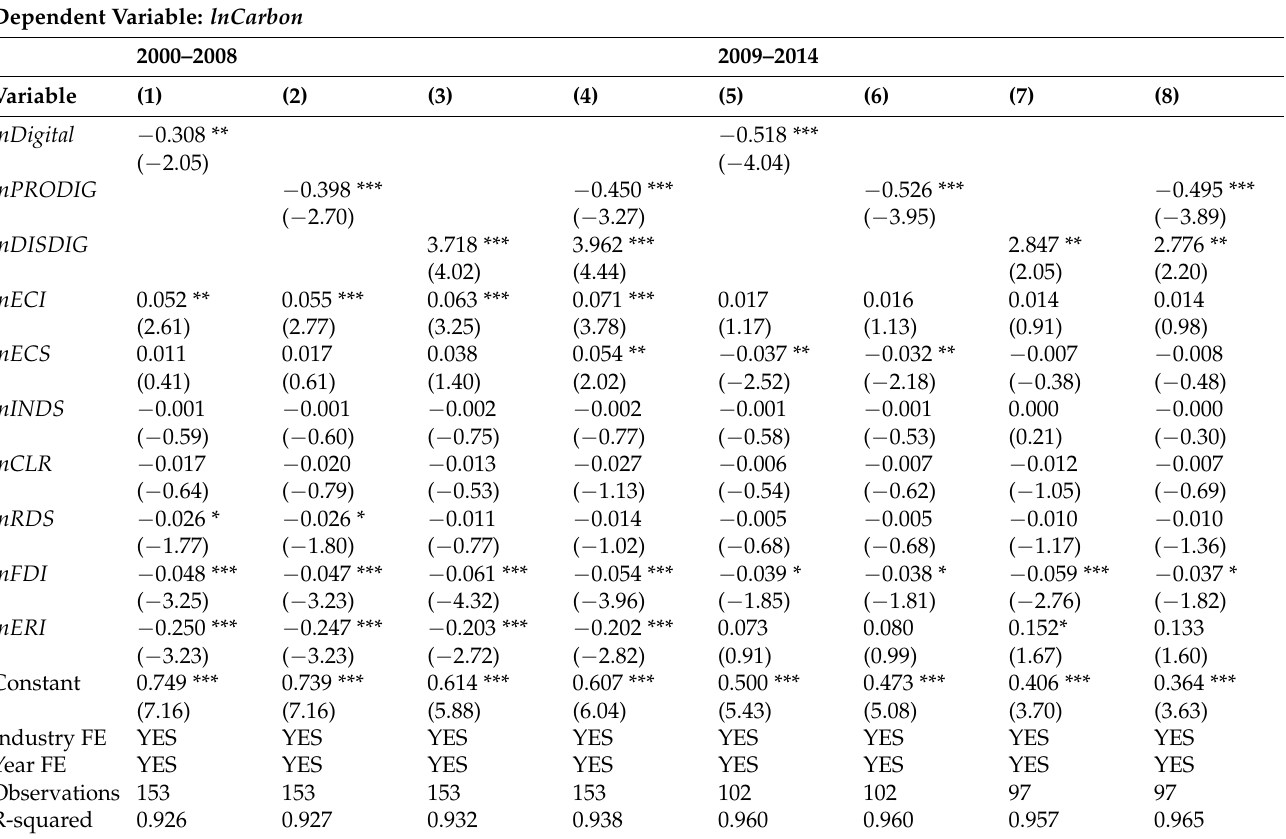
Table 6. Regression results after the sample time period is separated into two time